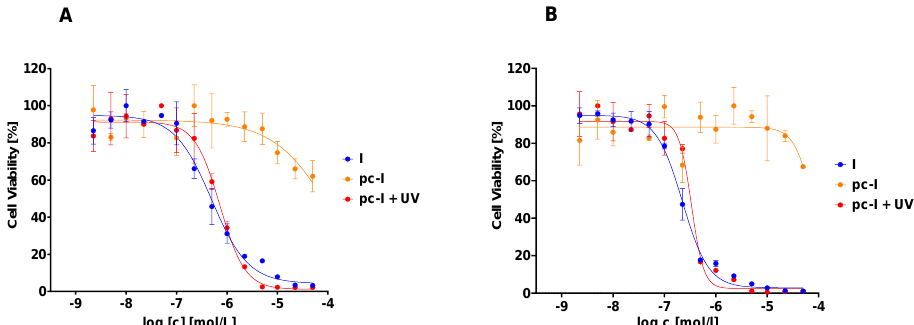
Figure 5. Representative concentration-effect curves of the MTT cell viability assays of pc-I and I . ( A ) MV-3 cell line, ( B ) A2780 cell line. UV irradiation was executed at 365 nm for 10 min. Table 2. Inhibitory activity of photocaged pc-I (with and without UV irradiation) and I against the MV-3 and A2780 cell line a .